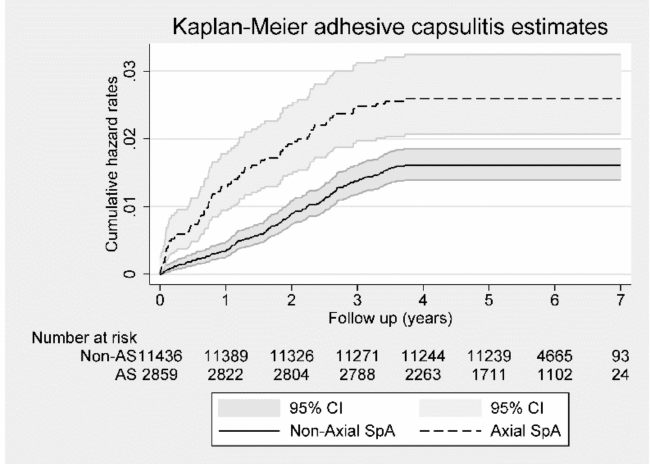
Figure 2. Kaplan–Meier hazard curve for adhesive capsulitis in patients with axial spondyloarthritis (Axial SpA) and control subjects for the 7-year follow-up